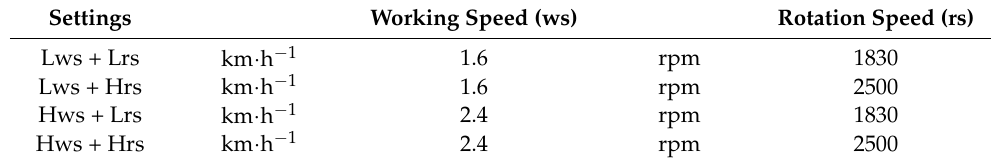
Table 2. Main properties of the research concerning the tested setting configurations.